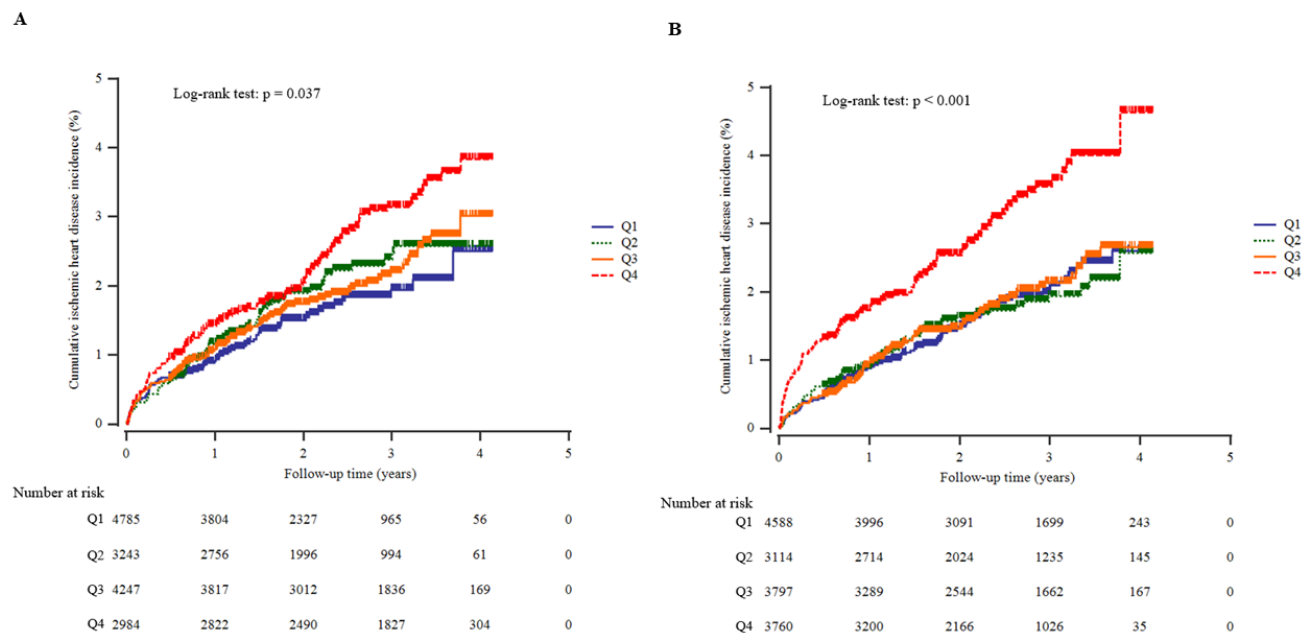
Figure 2. The cumulative probability of ischemic heart disease according to serum calcium quartiles ( A ) and phosphate quartiles ( B ) using Kaplan–Meier plots.